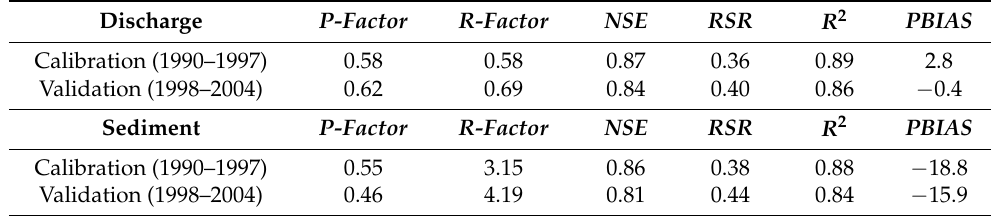
Table 3. Statistical results of calibration and